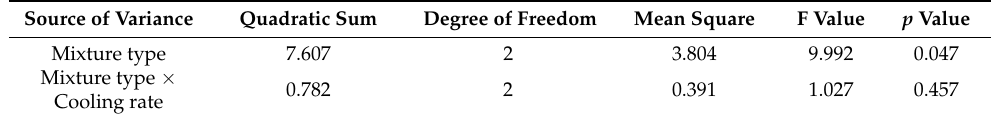
Table 9. Covariance analysis of the effect of the mixture type (matrix asphalt).